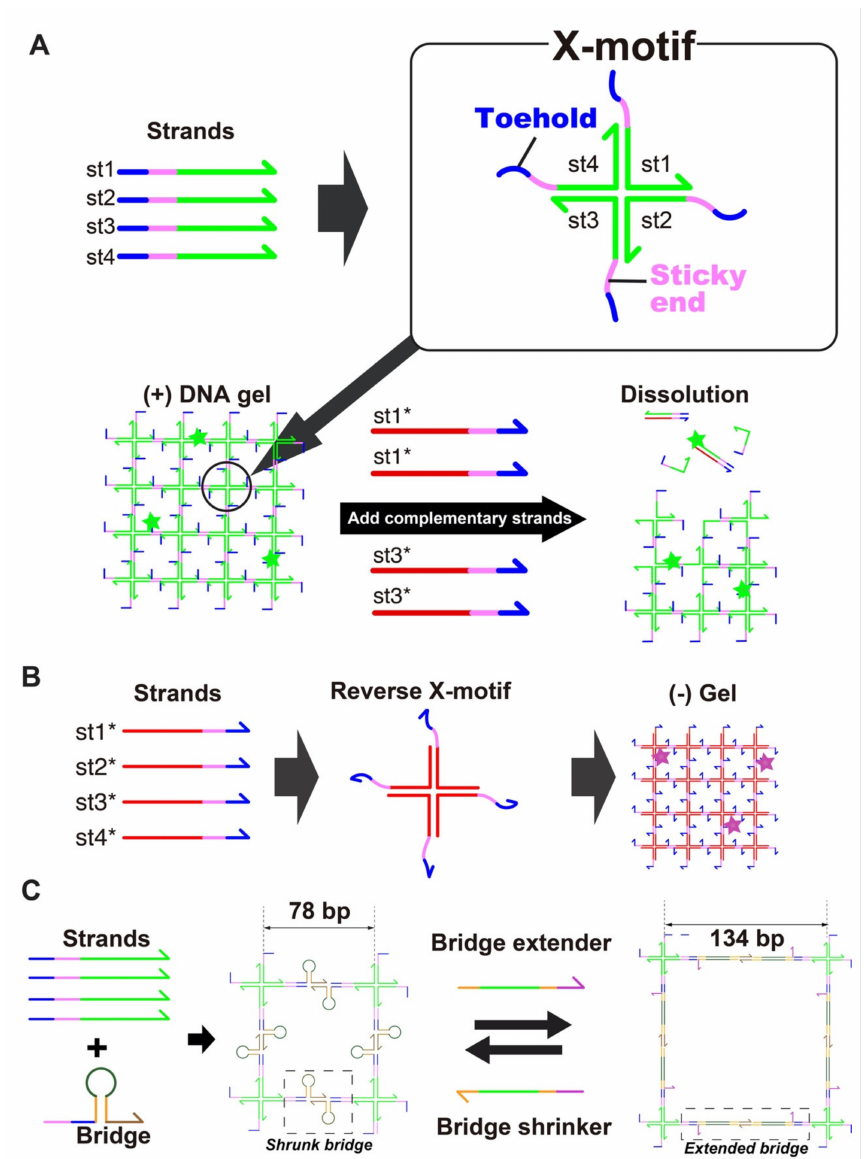
Figure 1. ( A )Assembly of the DNA hydrogel. The DNA gel forms hierarchically. The four constituent strands (st1, st2, st3, and st4) first mutually bind to form a X shaped motif, a Holliday junction, through the green domains. Each junction exposes 4 sticky-ends (colored pink) by which it binds to other junctions to form a 3D gel. The strands also expose a toehold domain (blue). When a complementary strand (st1*) is added to the solution, this toehold guides and directs the displacement of the target strand (st1), stripping it from the Holliday junction and disrupting the structure. ( B ) Assembly of the (-) DNA hydrogel. Complementary strands of (+) strands also forms a mesh structure, leading to the formation of a gel. ( C ) Controllable swelling and shrinking of DNA gel. A stem-loop structure (a bridge) is installed in the gel structure, bridging two X-motifs. This bridge is extended or shrunk with the addition of extender and shrinker strands, which convert the bridge between a hairpin structure and fully extended duplex